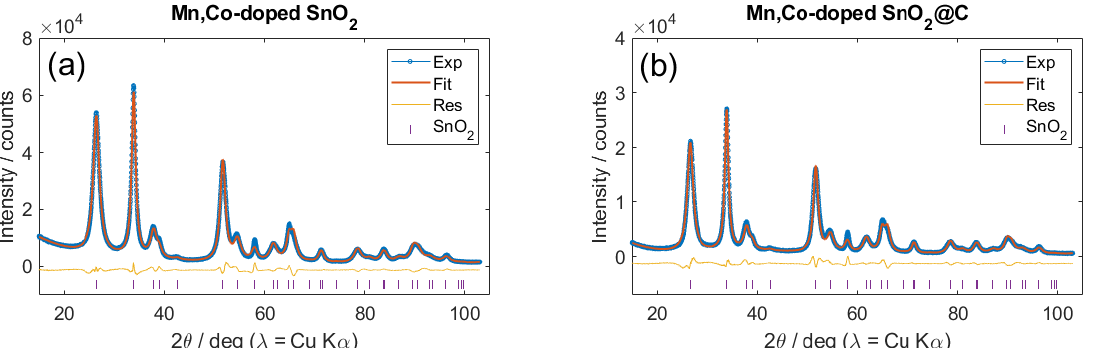
Figure 3. XRD patterns and the corresponding Rietveld refinement for ( a ) SCMO and ( b ) SCMO@C. Each panel contains the experimental pattern, the Rietveld refinement, the residual curve, and the expected reflections for the SnO 2 phase (PDF 01-070-6995).